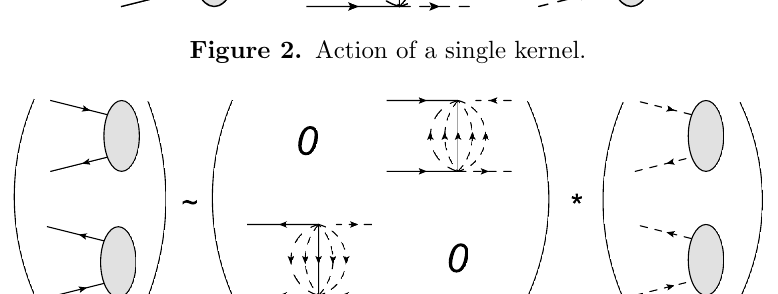
Figure 3. The eigenfunctions come in pairs. The two kernels in the 2 (cid:2) 2 matrix give identical contributions to the eigenvalue matrix (3.22), which leads to the extra (cid:27) 1